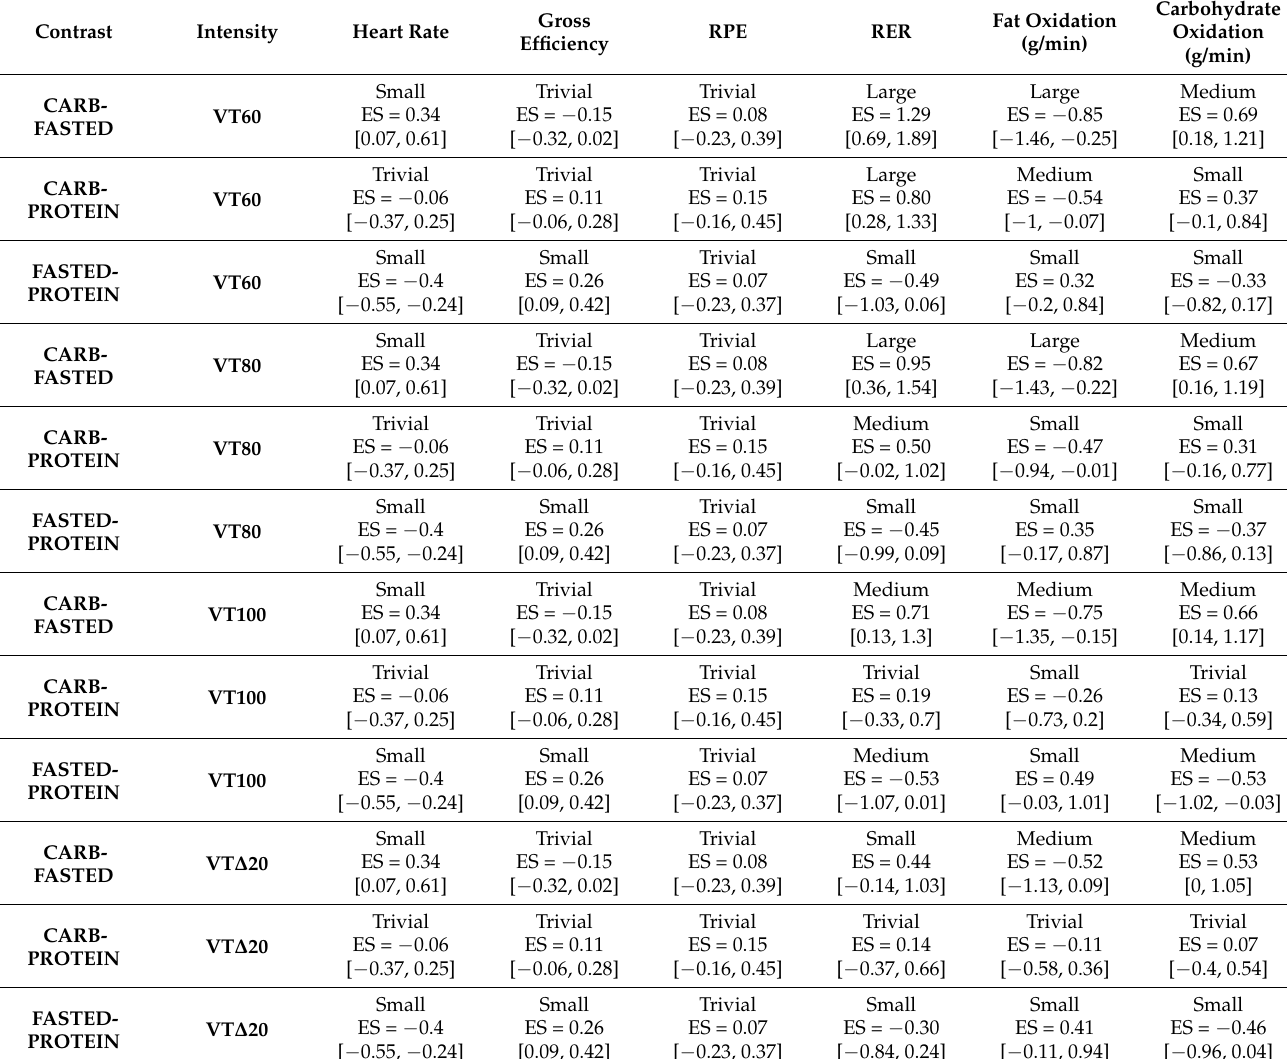
Table 1. Effect sizes [95% confidence intervals] for all contrasts during submaximal